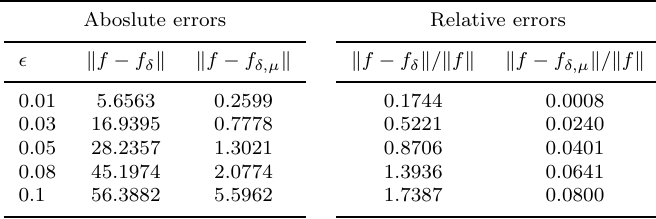
Table 3. Example 3: Errors assuming α 2 = 0 . 2 , β = (0 , 0) ,ν = 0 . 999 ,t 0 = 1 ,p = 1. Aboslute errors